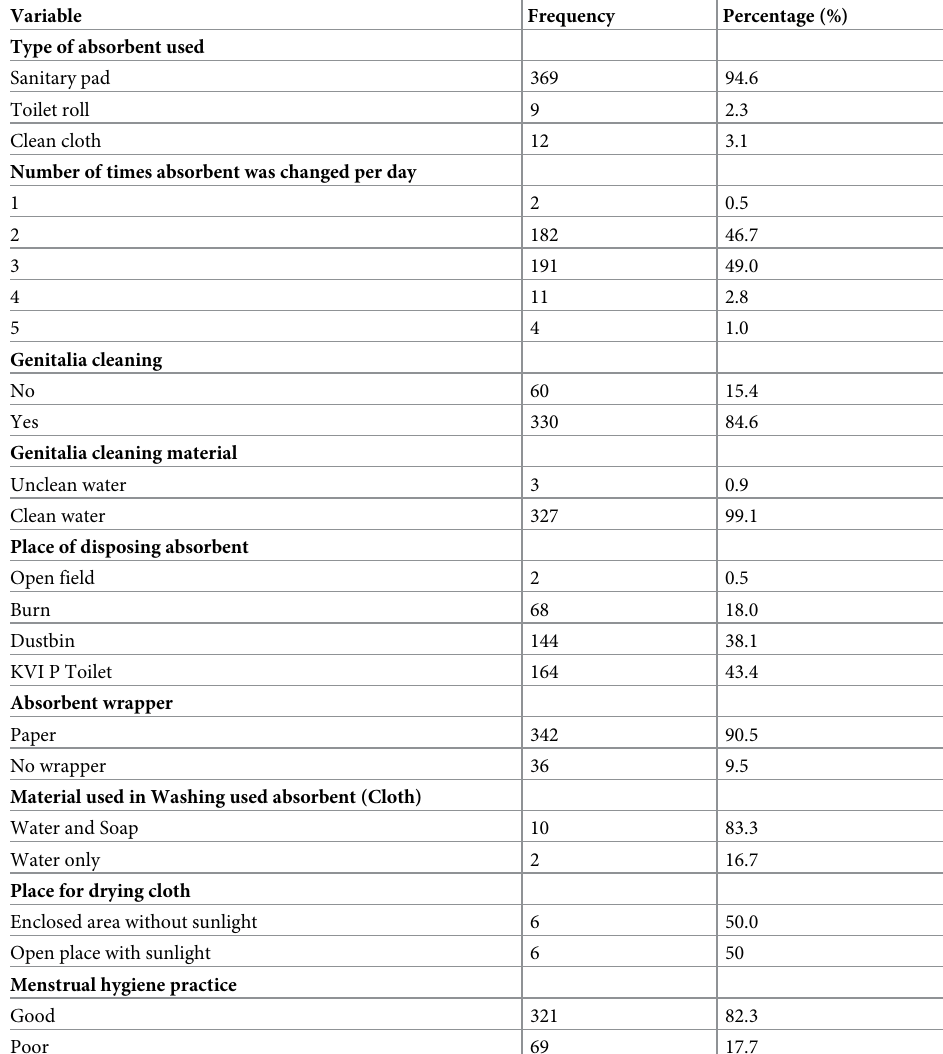
Table 3. Menstrual hygiene